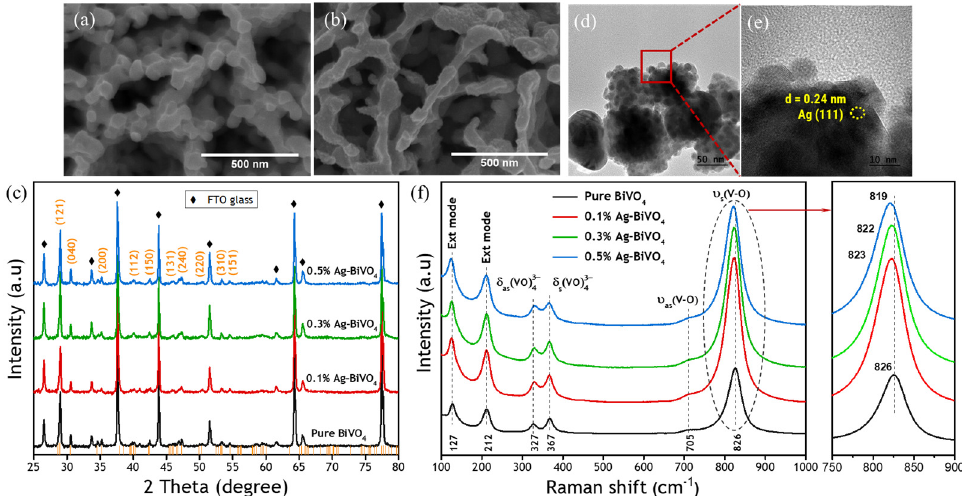
Figure 1. SEM images of surfaces of ( a ) bare BiVO 4 and ( b ) 0.5% Ag–BiVO 4 ; ( c ) XRD patterns of same with indicated FTO glass signals. Orange, vertical lines are standard peaks of monoclinic BiVO 4 (JCPDS 00 − 14 − 0688); TEM images of 0.5% Ag–BiVO 4 at different magnifications: ( d ) 50 nm and ( e ) 10 nm scale bar. ( f ) Raman spectra of bare BiVO 4 and Ag–BiVO 4 samples with assigned stretching and bending modes, respectively